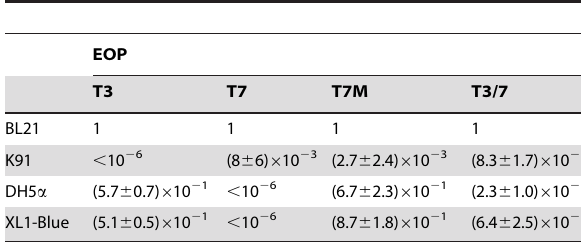
Table 1. Efficiency of plating of phages on E. coli female and male strains determined at 37 u